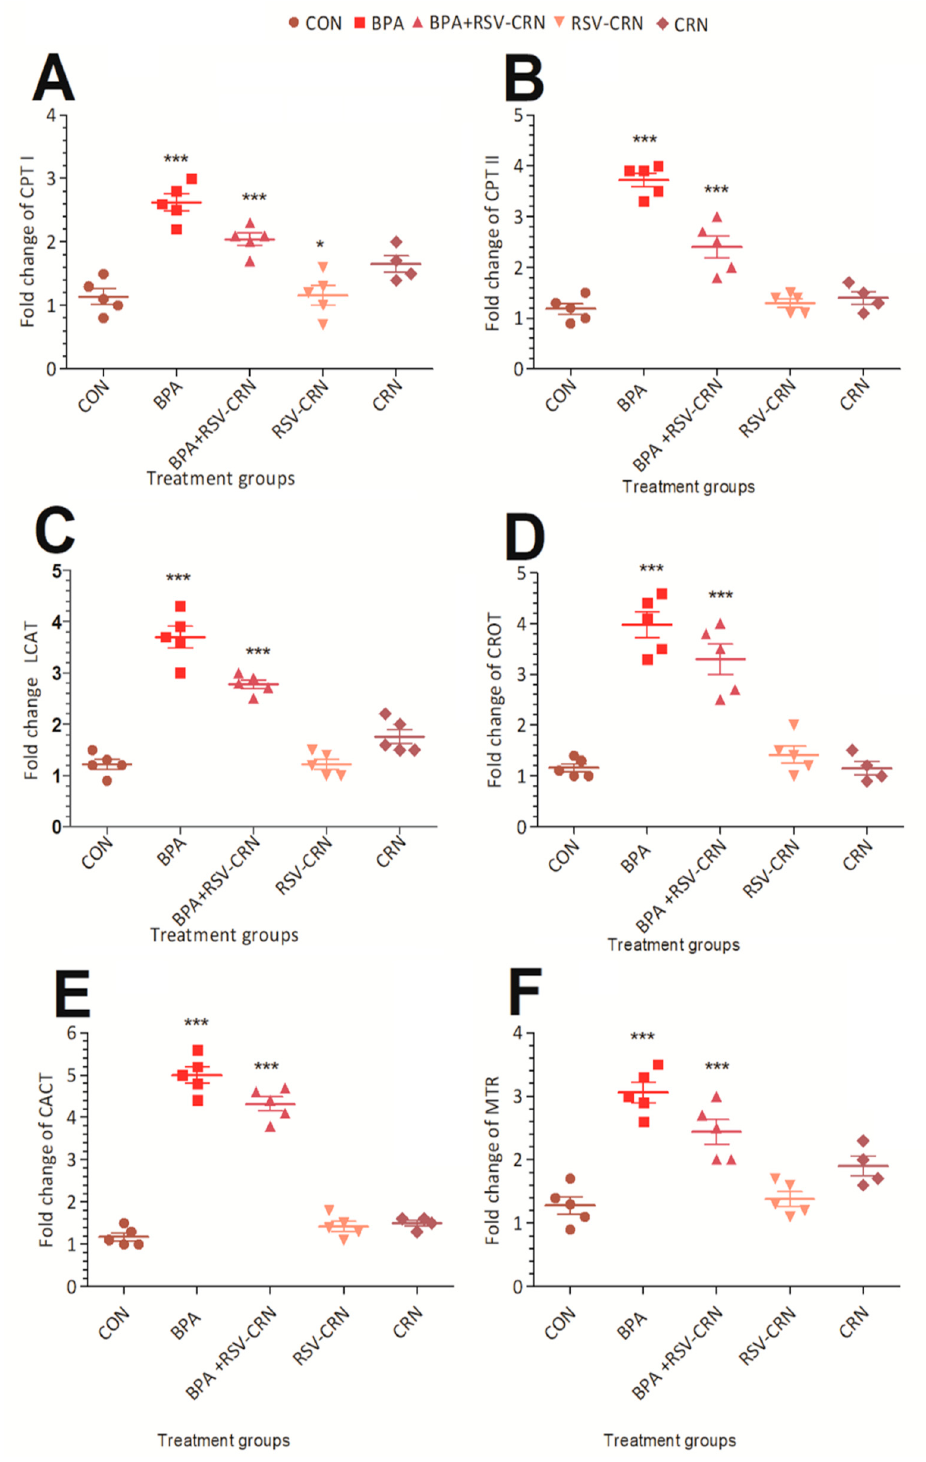
Figure 4. Graphical representation of the effects of BPA on mRNA expression of the ( A ) CPT I, ( B ) CPT II, ( C ) LCAT, ( D ) CROT, ( E ) CACT, and ( F ) MTR genes in all groups, i.e., CON, BPA, BPA+RSV- CRN, RSV-CRN, and CRN. The quantitative analysis was performed at the end of the experiment. Data were analyzed using one-way ANOVA. * is used to show the significance of the results where *** means a highly significant difference from the control group. Abbreviations: CPT I: Carnitine palmitoyltransferase I; CPT II: Carnitine palmitoyltransferase II; LCAT: Lecithin–cholesterol acyl- transferase; CROT: Carnitine O-octanoyltransferase; CACT: Mitochondrial carnitine/acylcarnitine carrier protein; MTR: 5-methyltetrahydrofolate-homocysteine methyltransferase.